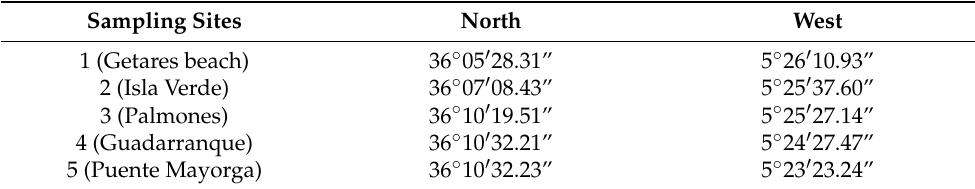
Table 1. Geographical coordinates of the sampling